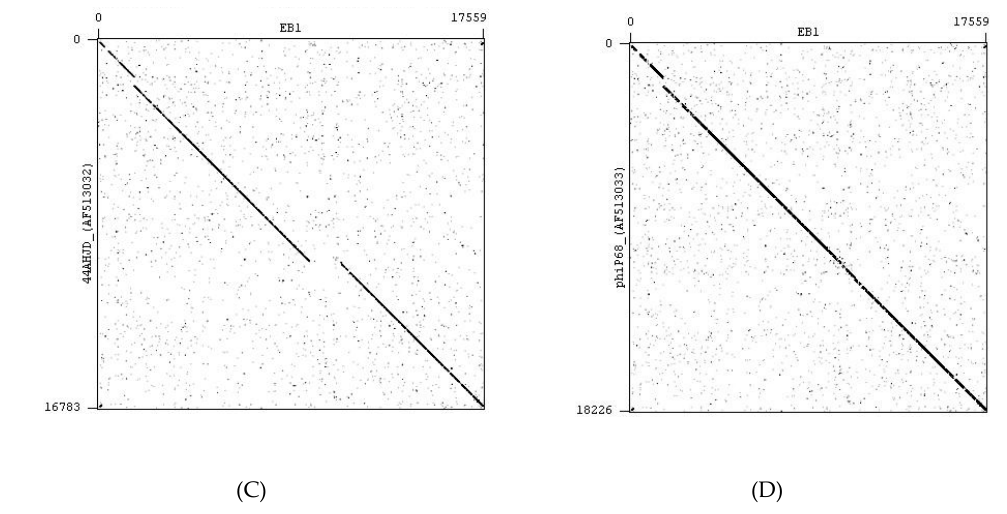
Figure 6. Local comparison of two phage genomic sequences (dotplot) calculated by Gepard software version 1.40: A —comparison of genomic sequences of phages EB1 and PSa3; B —comparison of genomic sequences of phages EB1 and 66; C —comparison of genomic sequences of phages EB1 and 44AHDJ; D —comparison of genomic sequences of phages EB1 and phiP68.